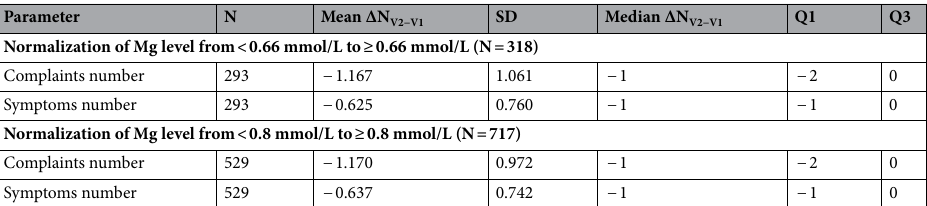
Table 2. Changes in the number of complaints and threatened miscarriage symptoms in pregnant women with symptoms of Mg deficiency in whom total serum Mg level was normalized. ΔN V2−V1, difference between Visit 1 and Visit 2 in the number of symptoms or complaints reported; Mg magnesium; N number of women; Q quartile; SD standard deviation.